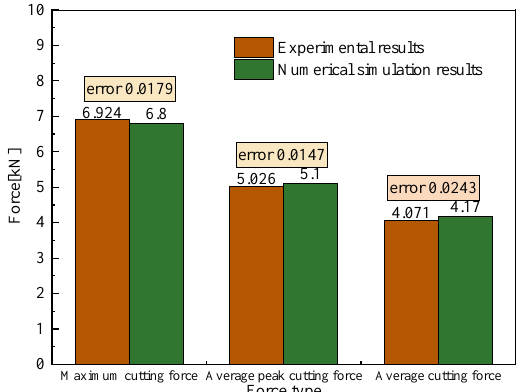
Figure 6. The results of conical pick rock-cutting numerical simulation.